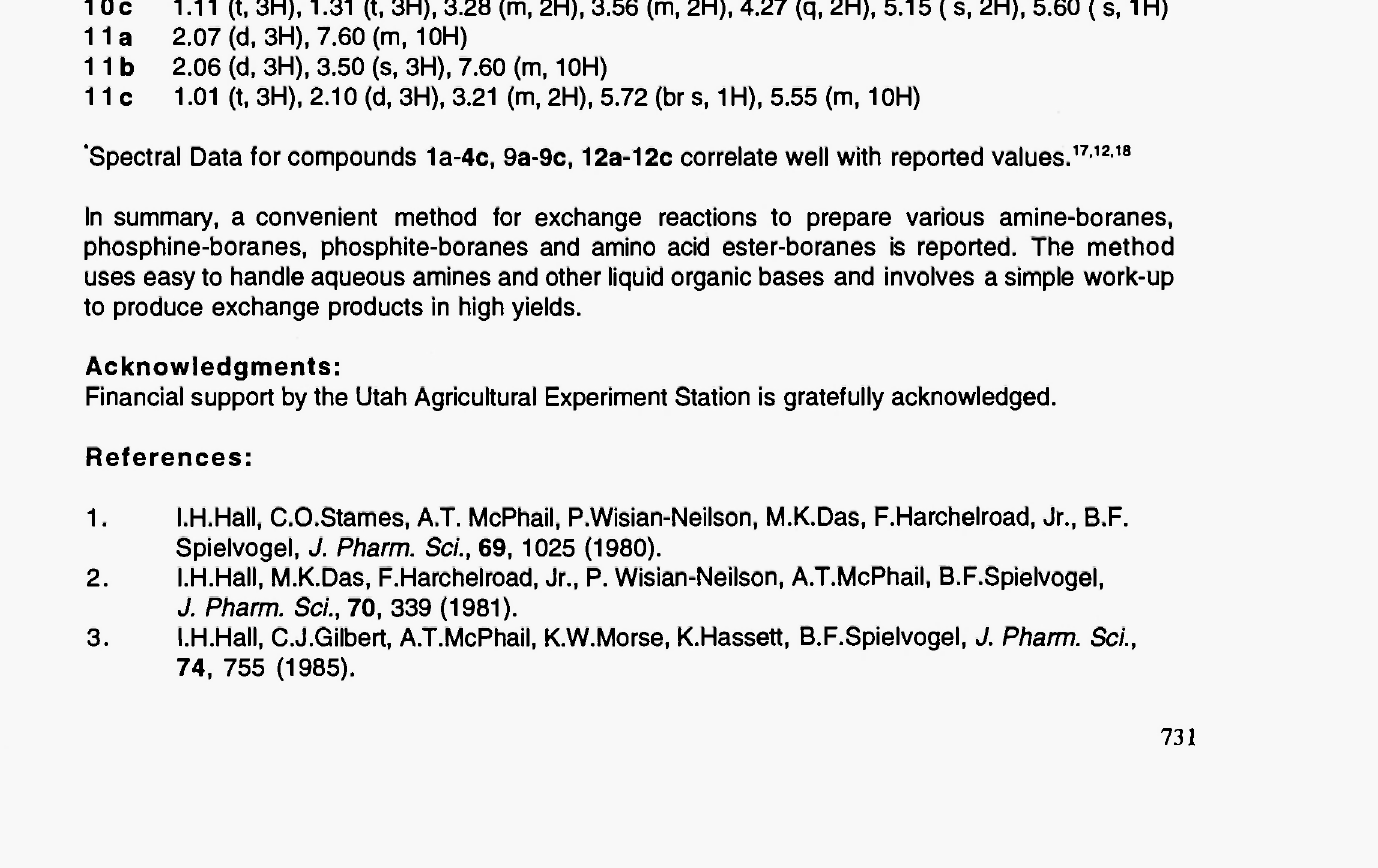
) Spectroscopic Data for R BH 3